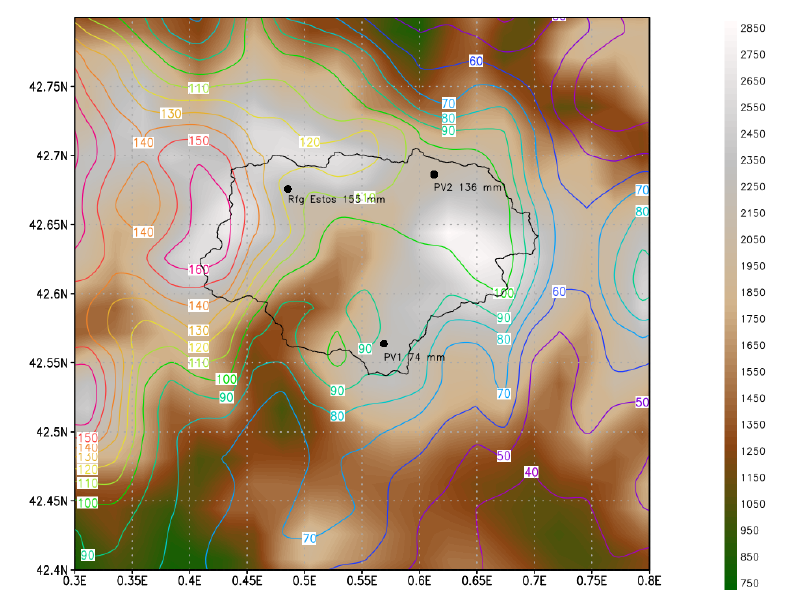
Figure 4. Simulated precipitation [mm] contour map by the WRF, in black is the Ésera catchment. Background colour is model surface elevation as indicated by the legend on the right side. The points indicate accumulated precipitation measurements at two tipping bucket pluviometers and in a totaliser pluviometer at the Refugio de Estós (Estós mountain Hut). The totaliser data is provided by Serrano Notivoli et al. [68], but they have not been